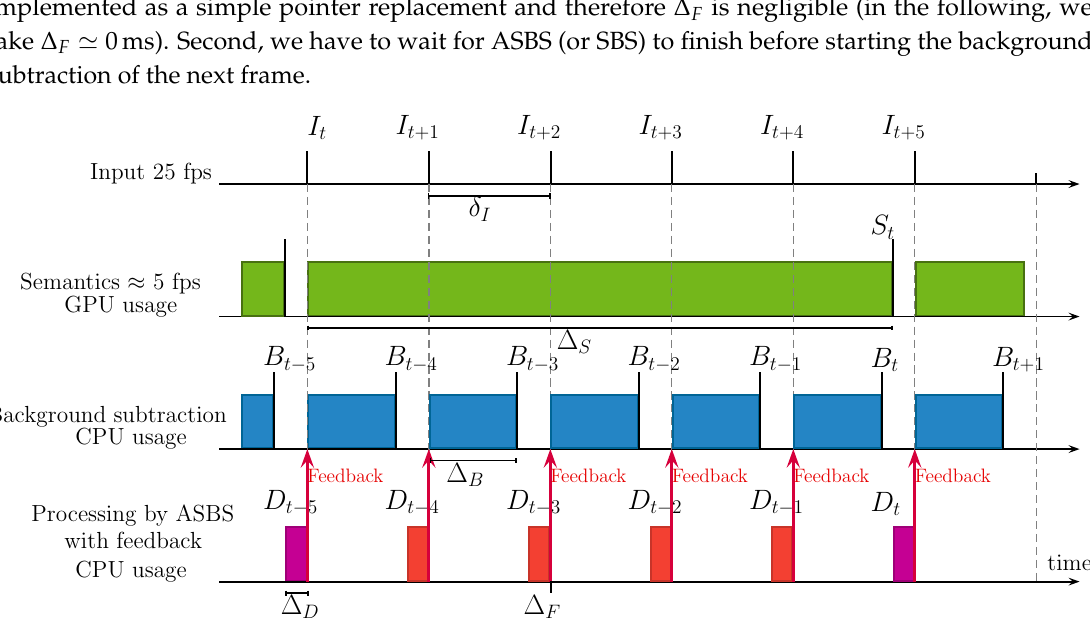
Figure 11. Timing diagram of ASBS with a feedback mechanism in the case of a real-time BGS algorithm ( ∆ B < δ I ) satisfying the condition ∆ B + ∆ D < δ I and the computation of semantics being not real-time ( ∆ S > δ I ). Note that the feedback time ∆ F is